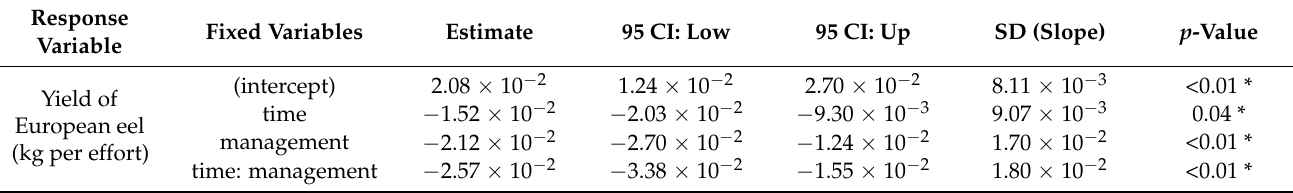
Table 4. The effect of time and the increased minimum legal angling size on the yield of the European eel Anguilla anguilla . The minimum legal angling size of the European eel was increased from 45 cm to 50 cm TL in 2011. The data were collected by the Czech Fishing Union on 176 studied and 25 control river stretches over the years 2005–2018. They originate from angling logbooks that were submitted by recreational